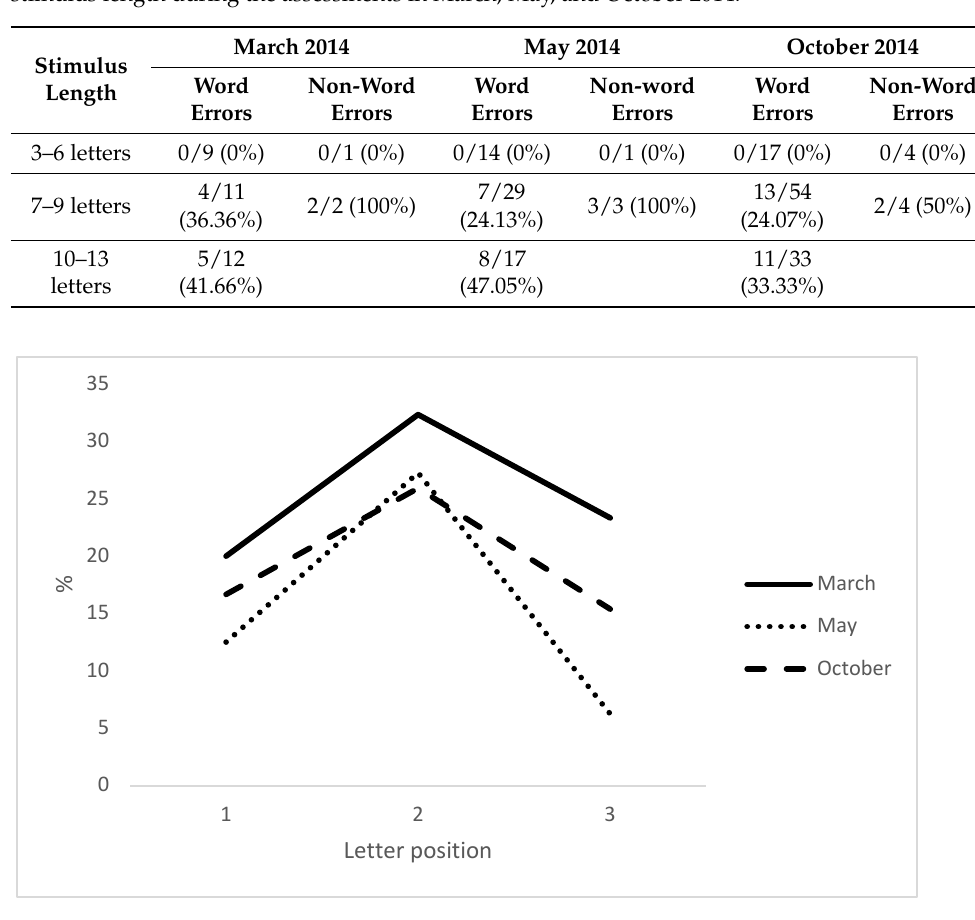
Figure 3. Distribution of errors in function of the letter positions (1, 2 and 3) during the assessments in March, May, and October 2014.